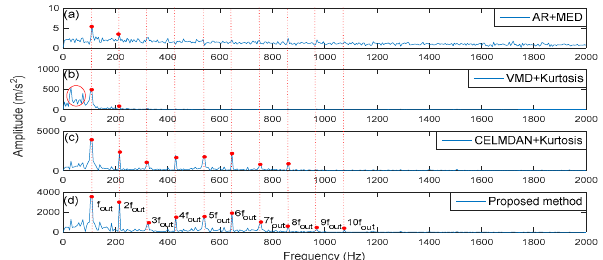
Figure 28. Comparison of fault extraction using the different methods.